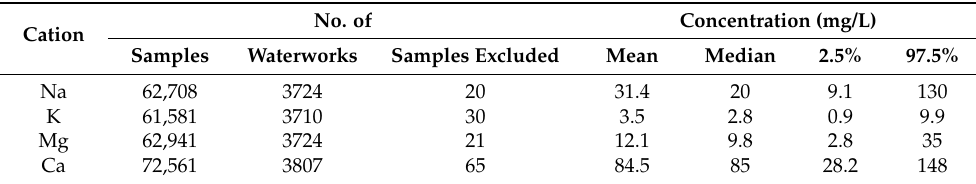
Table 1. Descriptive analysis of selected geogenic cations in drinking water in Denmark (1980–2017) given by means of number of drinking water samples, mean, median, 2.5% and 97.5% percentiles of the concentration for each of the cations Na, K, Mg and Ca.